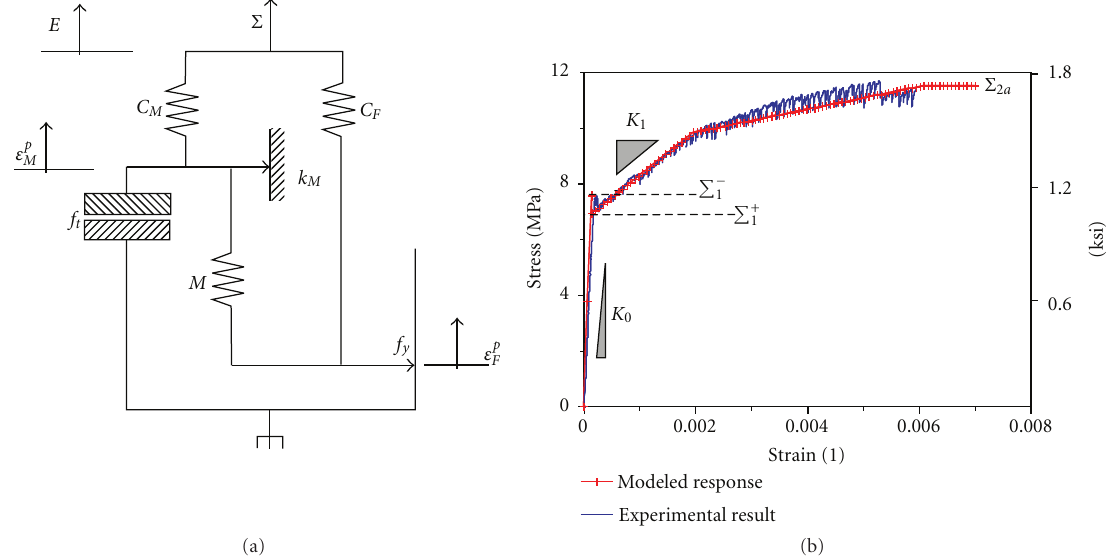
Figure 4: The two-phase rheological model of UHPC (a) and the comparison of model prediction with experimental data